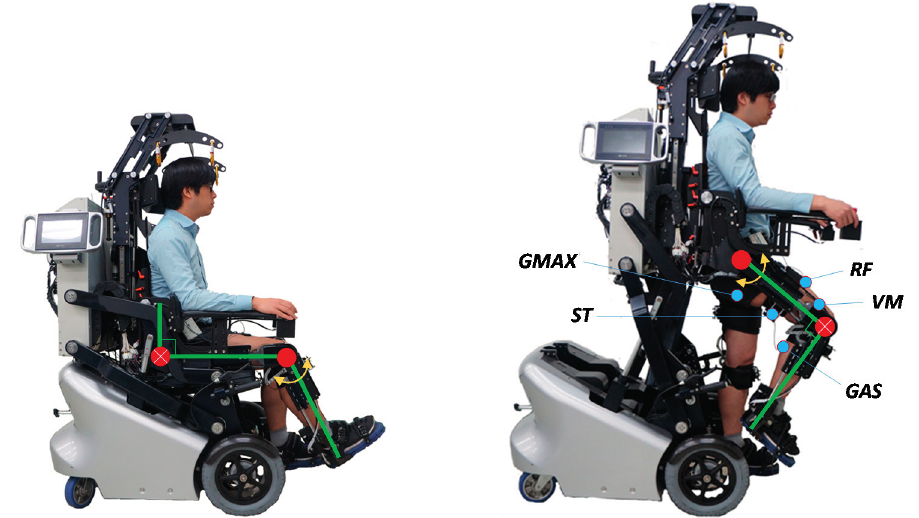
Figure 3. Experimental setup for parameter identification. ( a ) Identification of the lower leg parameters; ( b ) Identification of the thigh